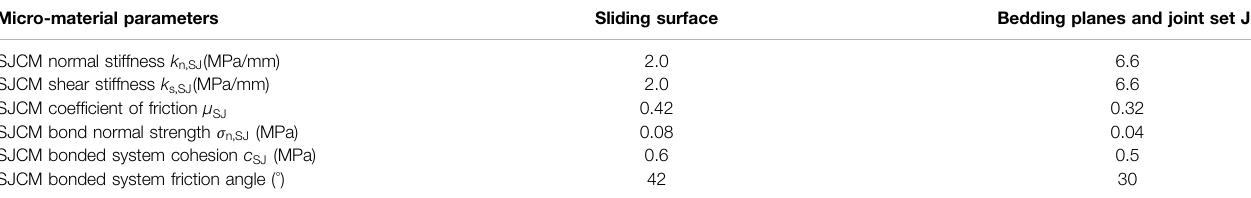
TABLE 2 | Calibrated parameters for smooth joint contact model (SJCM). Micro-material parameters